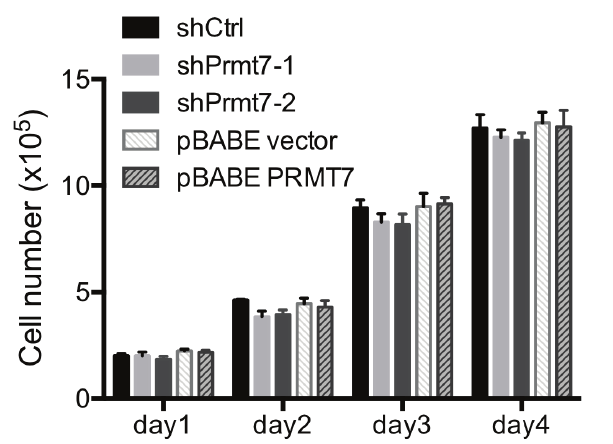
cells compared to the scrambled shRNA control cells (Figure 2B).